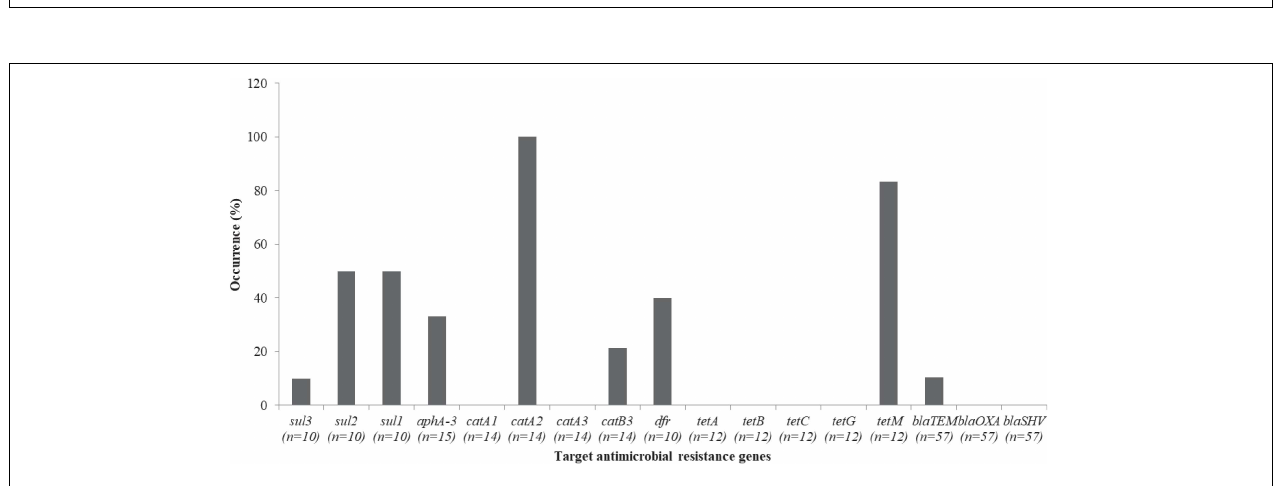
FIGURE 6 | MAR index of V. parahaemolyticus recovered from African salads. Others = Vp014, Vp026, Vp038, Vp043, Vp053, Vp056, Vp072, Vp111, Vp149, Vp165, Vp172, Vp175, Vp180, Vp185, Vp194, Vp196, Vp224, and Vp152.